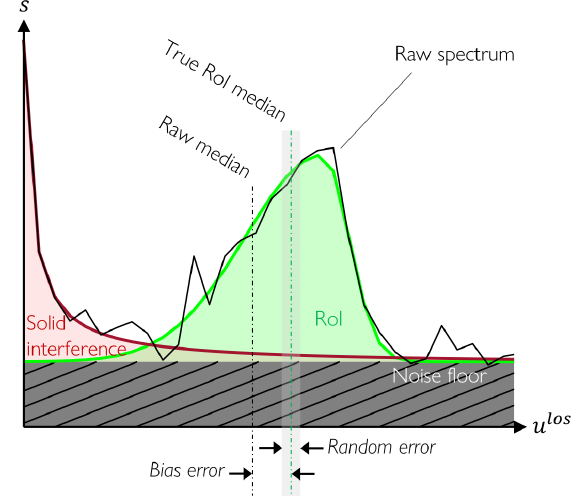
Figure 1. Example of a power spectral density, s , distribution ver- sus line-of-sight velocity, u los , of a raw CW lidar return illustrating the contamination of the region of interest (RoI) by solid interfer- ence and amplitude noise. The raw geometric median contains bias error due to the solid interference as well as random error due to the amplitude noise. Figure adapted from Brown and Herges